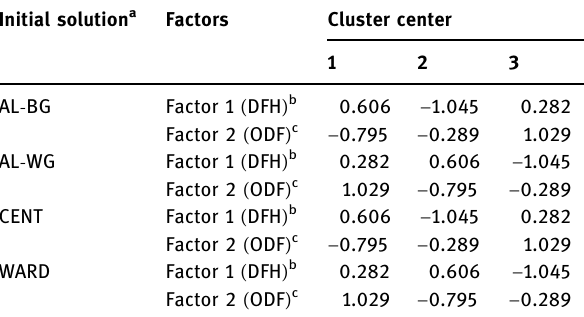
Table 8: Cluster centers for the k - means with di ff erent initial solutions Initial solution a